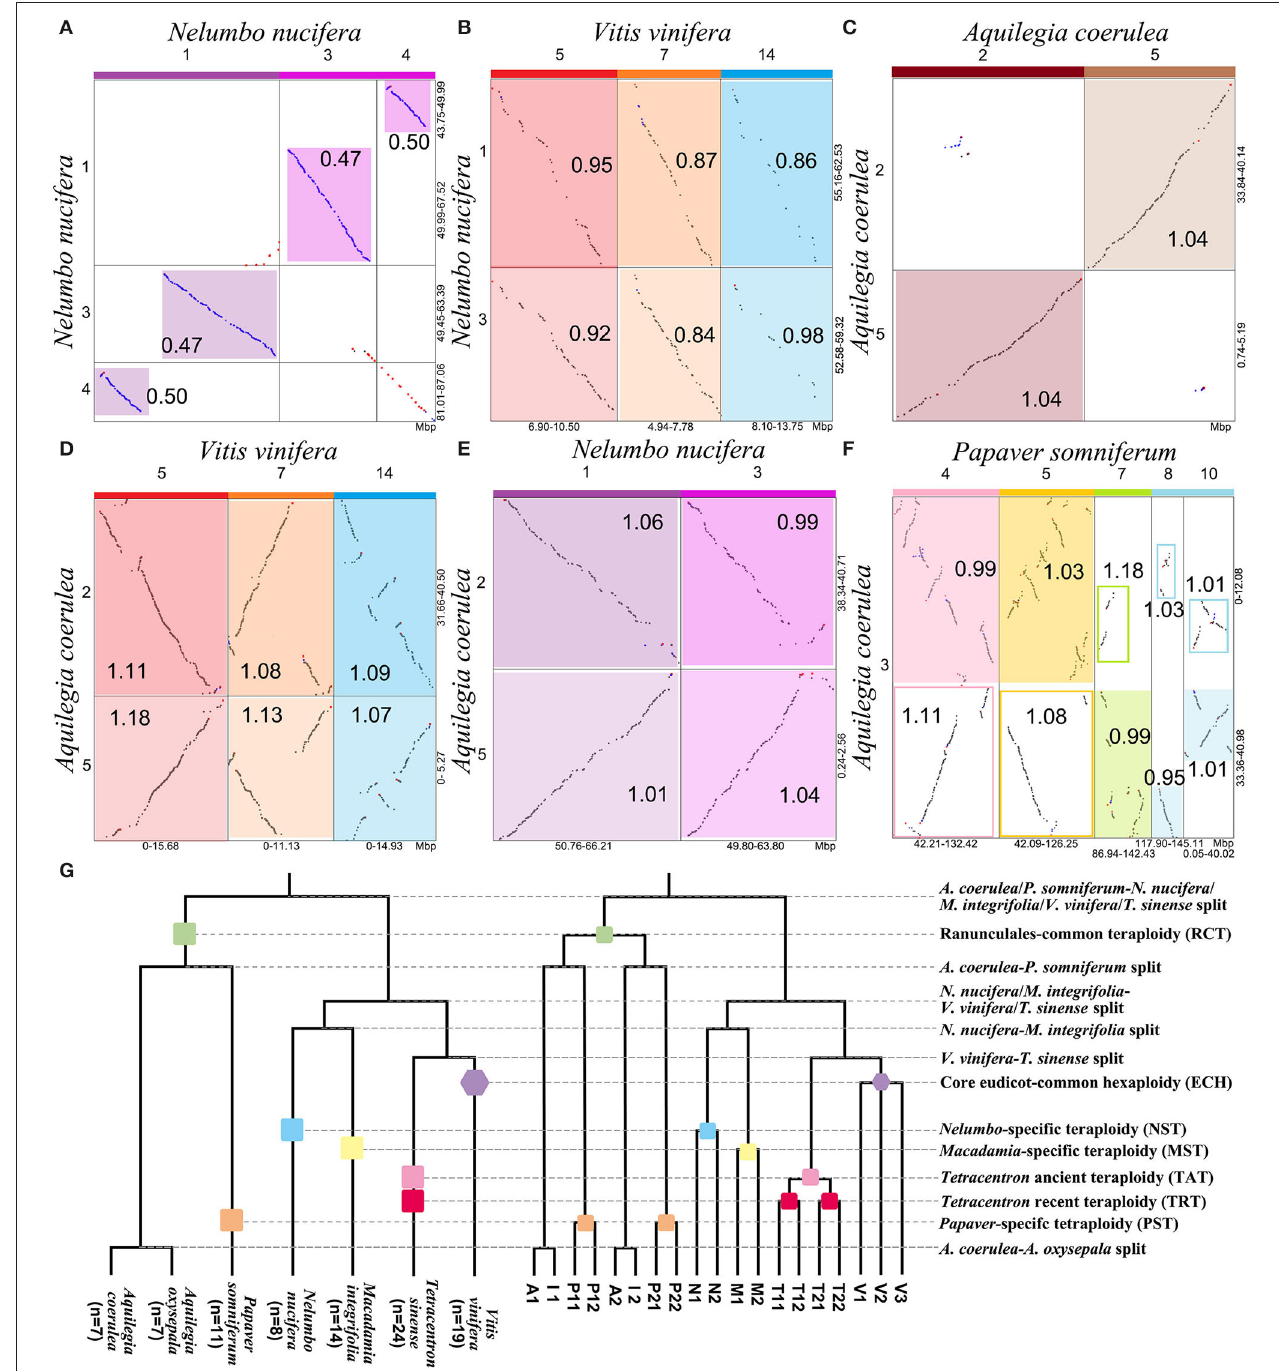
FIGURE 2 | Intragenomic and intergenomic local dot plots and phylogenetic tree. Local dot plot and Ks medians (A) within N. nucifera , (B) between V. vinifera and N. nucifera , (C) within A. coerulea , (D) between V. vinifera and A. coerulea , (E) between N. nucifera and A. coerulea , and (F) between A. coerulea and P. somniferum . On the top of the local dot plots, the colored blocks represent the paralogous chromosomes produced by WGD. The highlighted areas of different brightness represent homologous regions, and the outparalogous regions between genomes are framed by solid lines. (G) Species and gene phylogenetic trees of A. coerulea (A), A. oxysepala (I), N. nucifera (N), P. somniferum (P), M. integrifolia (M), T. sinense (T), and V. vinifera (V). The phylogenetic relationship was based on the current accepted topology (Angiosperm Phylogeny Website). A number of three paralogous genes produced by the ECH in the V. vinifera genome are denoted by V1, V2, and V3, and each has two orthologous genes in N. nucifera , A. coerulea , and M. integrifolia , and four in P. somniferum and T. sinense .